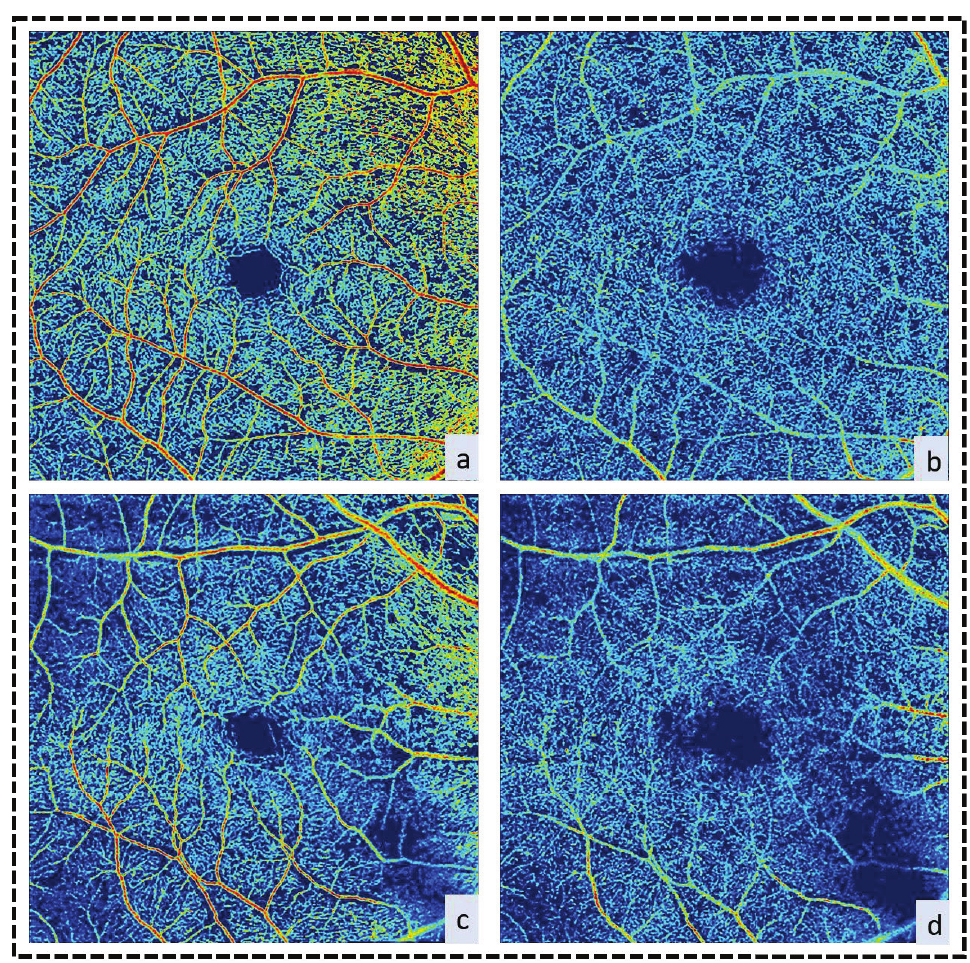
Figure 2. Vessels density. ( a ) SCP of normal control, ( b ) DCP of normal control, ( c ) SCP of the a diabetic patient, and ( d ) DCP of a diabetic patient. Table 2. The average VD in both normal and DR